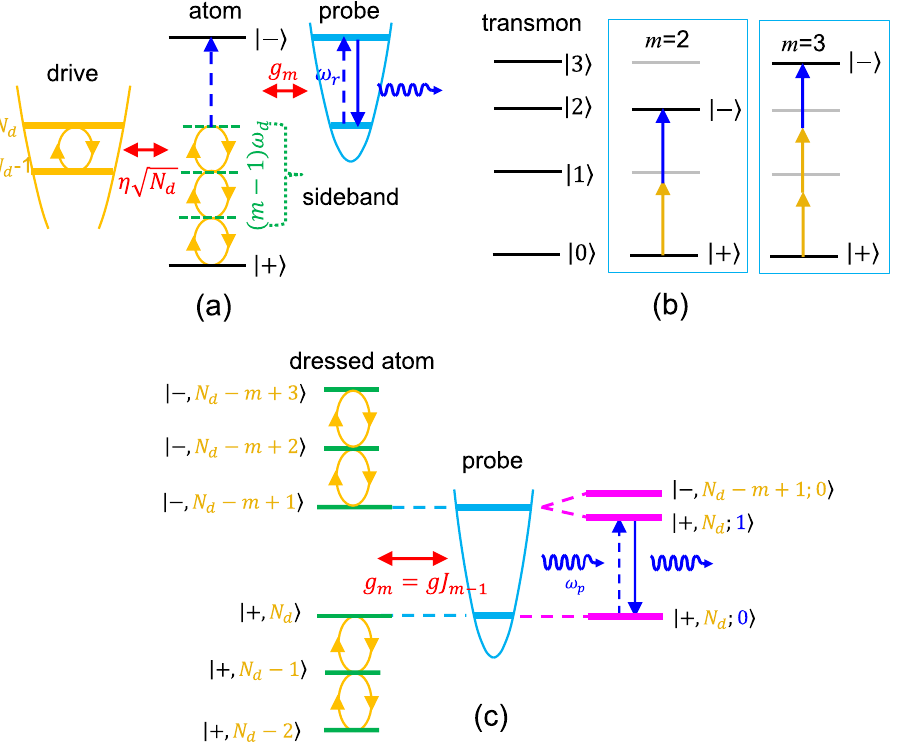
Figure 1. ( a ) The proposed scheme of circuit QED with a dressed artificial atom. A two-level atom is dressed with driving photon number N d with a bare coupling strength η at a sideband transition to an excited atom level . Transitions in the dressed state is in resonance to a probe resonator with a modulated coupling strength, |−� g m . ( b ) The energy diagram of a transmon. When m 3 , respectively. The orange and blue arrows illustrate the absorption of photons from the driving and probe | � resonators. ( c ) Dressed states are composite quantum states of sideband order (